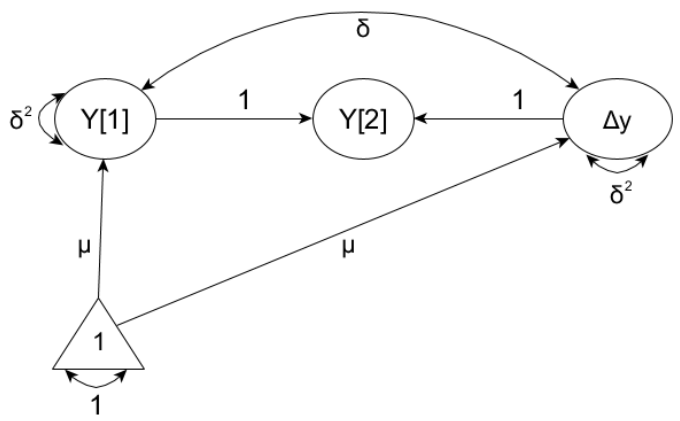
Figure 2. Latent difference score scheme (LDS) for the latent variable measured at two different times. Note: The change between Y 1 and Y 2 is estimated as a constant ∆ y (LDS); the lines with two arrows indicate correlations; the lines with one arrow are regression coefficients; the autoregressive path Y 1 → Y 2 and regression coefficient ∆ y → Y 2 have values set to 1 (one); the error associated with variable Y 2 and its constant are set to 0 (zero). The ∆ y variable is directly unobservable and estimated based on the transformation of the formula: Y [2] = Y [1] + ∆ y. The parameter δ 2 means variances, δ is the correlation, and μ means. The triangle represents the means’ structure.